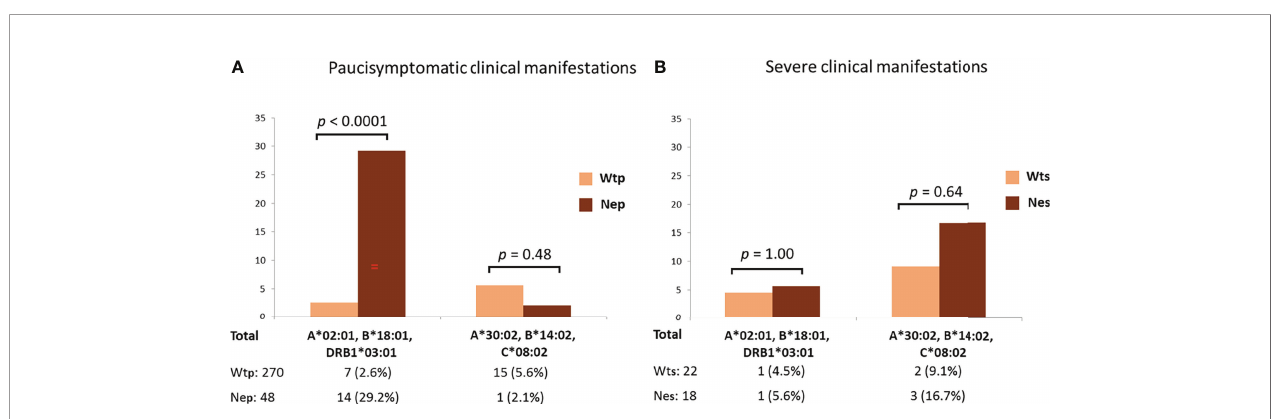
FIGURE 2 | Frequencies of the HLA-A*02:01, B*18:01, DRB*03:01 or HLA-A*30:02, B*14:02, C*08:02 three-loci extended haplotypes in asymptomatic, pauci- symptomatic, moderate (A) and severely ill (B) patients subdivided according to the presence of the Wild Type allele variant (homozygous for rs35044562/A = Wt) or Neanderthal allele variant (homozygous or heterozygous for rs35044562/G = Ne) of the leucine zipper transcription factor-like 1 ( LZTFL1 ) gene. P-values ( p ) were calculated using the two-tailed Fisher exact test. Wtp = pauci-symptomatic patients carrying the rs35044562/A variant allele; Nep = pauci-symptomatic patients carrying the rs35044562/G variant allele; Wts = severely ill patients with the rs35044562/A allelic variant; Nes = severely ill patients with the rs35044562/G variant